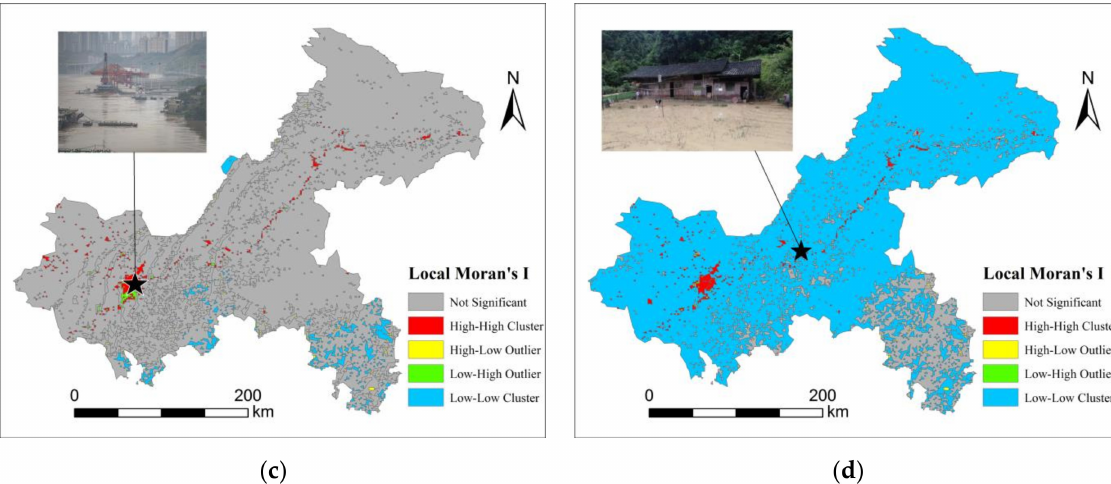
Figure 11. Distribution map of local spatial autocorrelation: ( a ) Spring, ( b ) Summer, ( c ) Fall, ( d ) Winter. Note: Not significant means that the representative flood risk has no significant spatial relationship in this area. High-high cluster and low-low cluster are the identification of high- and low-risk spots. High-low outlier and low-high outlier are used to convey that the hot spots and the cold spots are mixed with each other, which makes it impossible to identify the specific flood risk value in this